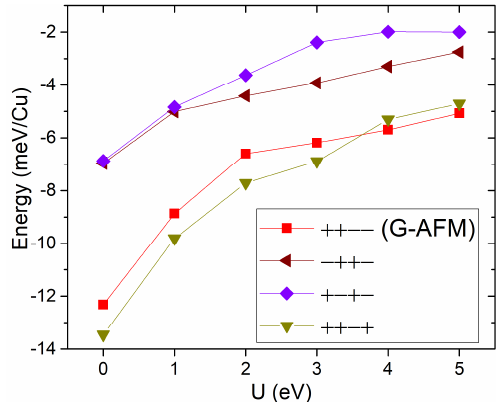
Figure 5. [Gua]Cu(H 2 POO) 3 GGA + U total energies relative to the ferromagnetic state as a function of U.